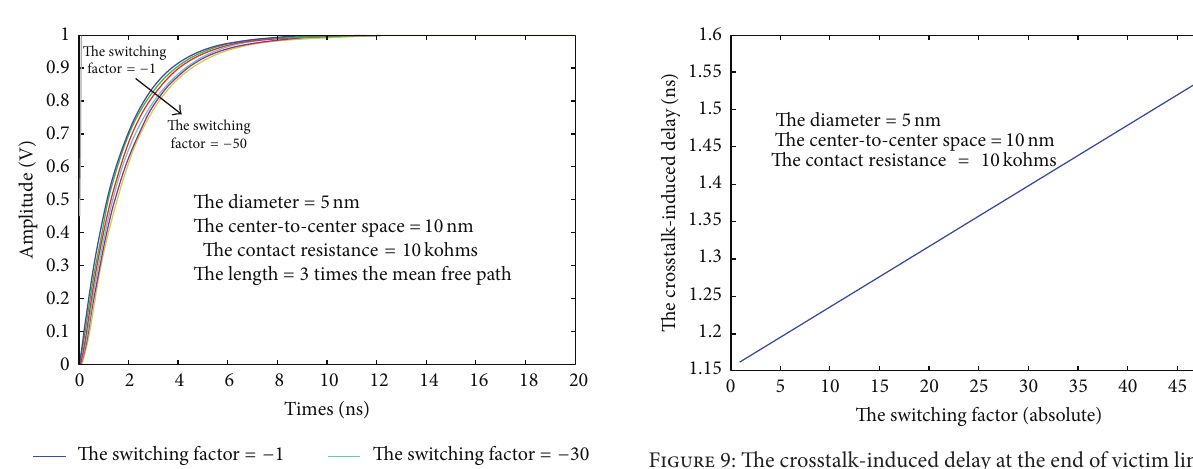
Figure 9: The crosstalk-induced delay at the end of victim line (the configuration of Figure 5), for various values of the switching